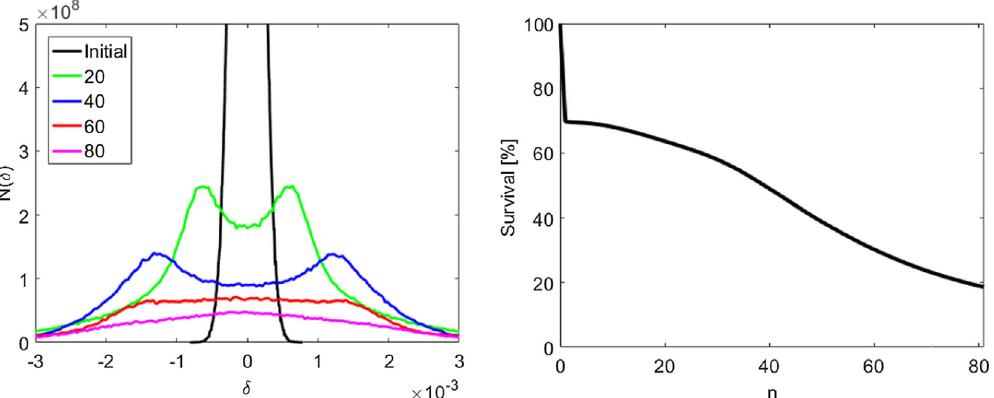
FIG. 20. Evolution of the energy spectrum and particle loss.